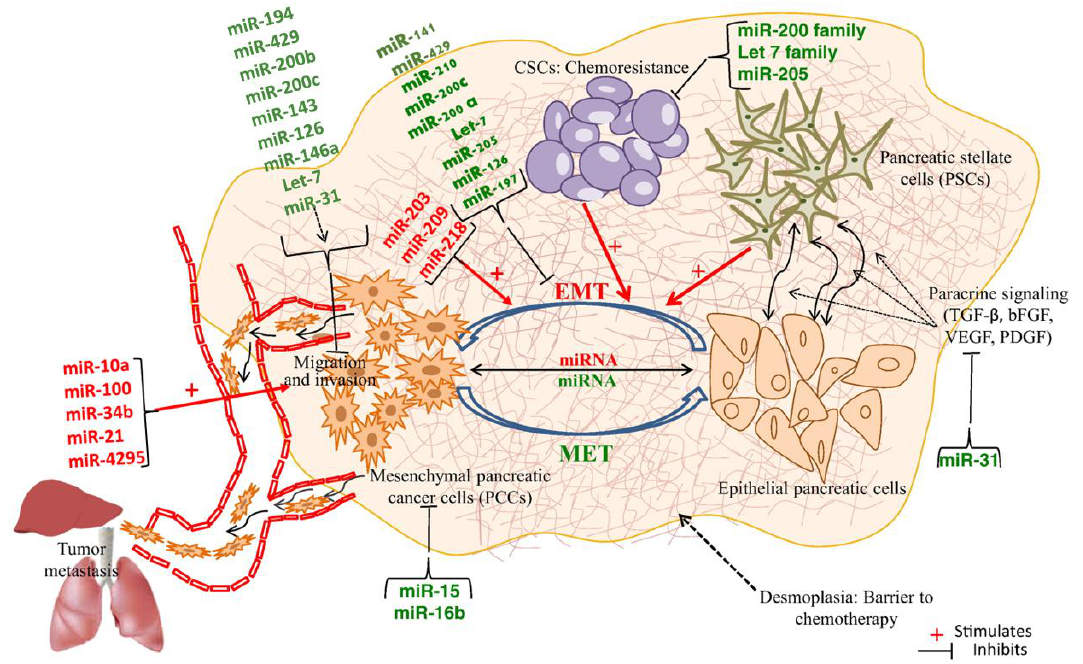
Figure 4. Schematic illustration of the role of tumor suppressor miRNAs at di ff erent stages of pancreatic ductal adenocarcinoma (PDAC). The figure depicts the interrelationship between pancreatic cancer cells (PCCs), pancreatic stellate cells (PSCs) and cancer stem cells (CSCs). The epithelial pancreatic cells undergo epithelial-mesenchymal transition (EMT) and become mesenchymal cells which bear high propensity to metastasize. EMT could be reversed back to mesenchymal-to-epithelial transition (MET) by the intervention of certain miRNAs. This figure is adopted and modified from [87], © 2015 Chitkara D, Mittal A, Mahato RI. under a CC BY-NC-SA 4.0